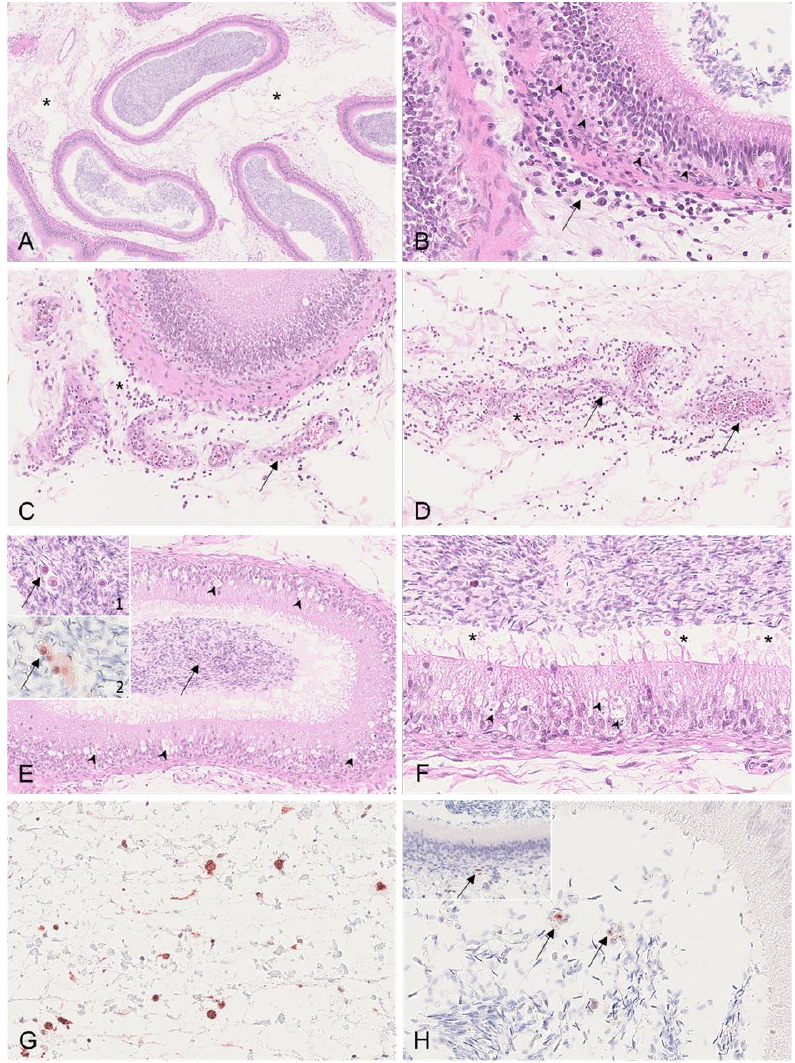
Figure 3. Histopathological findings of the epididymis in ASFV-infected boars. ( A ) HE, boar #1; diffuse severe edema of the epididymal head (asterisk). ( B ) HE, boar #1; the smooth muscle layer surrounding the epididymal tubules was expanded by infiltrating inflammatory cells consisting of neutrophils, histiocytes, and fewer lymphocytes (arrow). Inflammatory cells partially invaded the basal membrane (arrowhead). ( C ) HE, boar #1; necrotizing vasculitis and perivasculitis (arrow) of the epididymal interstitial vasculature adjacent to a mildly affected tubule, as shown in ( B ). The perivascular infiltrate was composed of neutrophils, histiocytes, and fewer lymphocytes (asterisk). ( D ) HE, boar #1; severe necrotizing vasculitis and perivasculitis (arrow). The tunica media and adventitia were diffusely necrotic (arrow). A focal mild hemorrhage is indicated (asterisk) within the infiltrated interstitium. ( E ) HE, boar #3; diffuse severe degeneration of the epididymal duct epithelium (arrowhead). Inset 1: Mononuclear cells were located within the tubular lumen (arrow). Inset 2: Intraluminal mononuclear cells were immunopositive for Iba-1 (arrow). ( F ) HE, boar #3; epididymal duct degeneration was characterized by cytoplasmic vacuolation, pyknosis, karyorrhexis, or karyolysis (arrowhead). Cellular debris (asterisk) admixed with spermatozoa was located within the tubule. ( G ) IHC, anti-p72, boar #1; the tunica vaginalis was infiltrated by numerous antigen- positive cells morphologically consistent with histiocytes. ( H ) IHC, anti-p72, boar #1; the lumen contained few ASFV antigen-positive cells (arrow). Inset: A single myofibroblast within the smooth muscle layer was positive for the p72